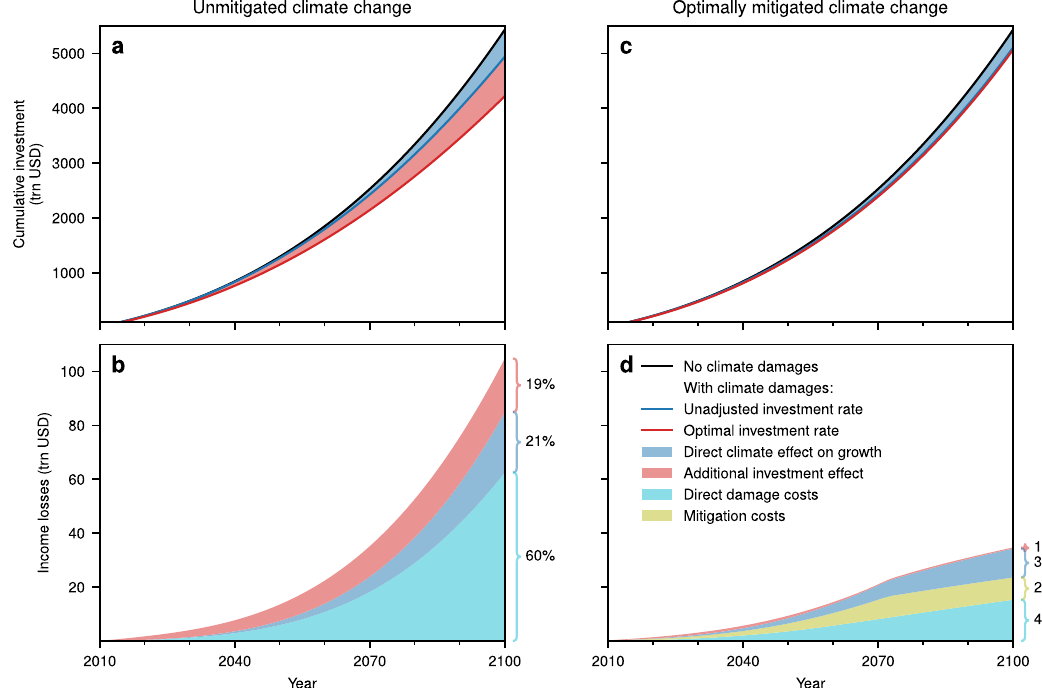
Fig. 4 The growth effects in the absence of climate policy (a, b) and under economically optimal mitigation of emissions (c, d). a Unadjusted investment behaviour and particularly optimal investment lead to cumulative investment gaps through the climate effect on growth and the additional investment effect, respectively. b The income losses that occur for unadjusted investment behaviour (direct damage costs and the hereby induced growth effects) and for optimal investment (additional investment effect). c, d Economically optimal climate policy diminishes the climate effect on growth and renders the additional investment effect to be insigni fi cant for ( c ) cumulative investment and for ( d ) income losses. Source data are provided as a Source Data fi